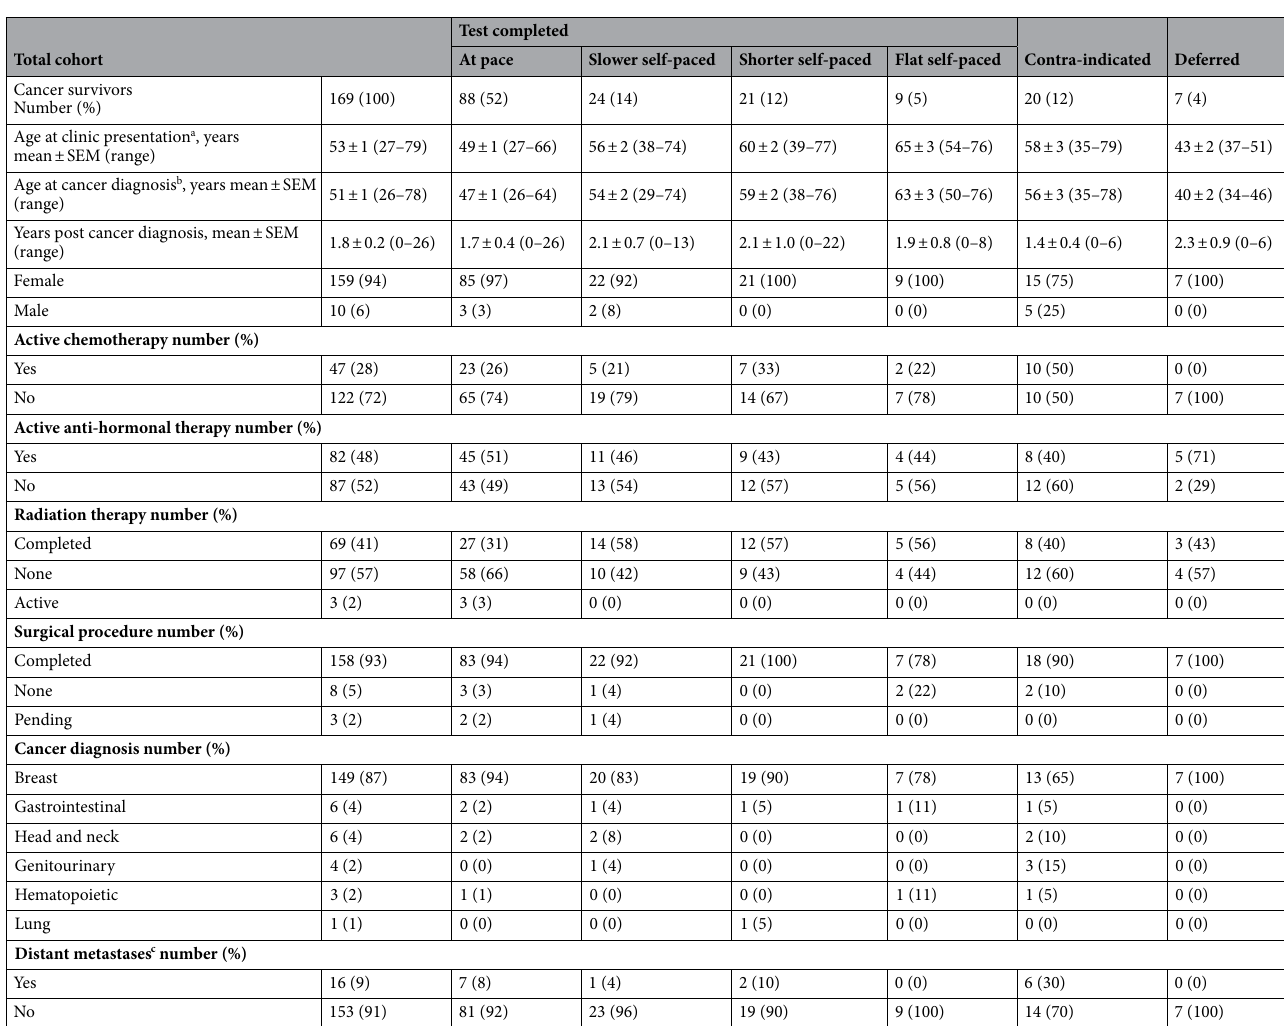
Table 3. Age, gender and cancer characteristics. a Age at clinic presentation: at pace vs. slower self- paced p = 0.0155, at pace vs. shorter self-paced p < 0.0001, at pace vs. flat self-paced p < 0.0001, at pace vs. contraindicated p = 0.0015, one-way ANOVA, Tukey’s multiple comparisons test. b Age at diagnosis: at pace vs. at pace vs. contraindicated p = 0.0142, Fisher’s exact, two-tailed. SEM: standard error of the